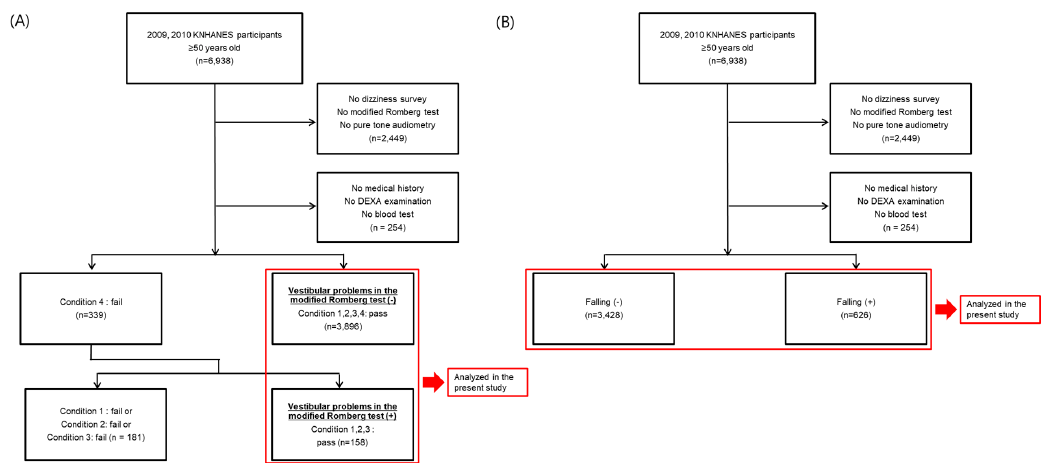
Figure 1. Schematic illustration of the method used for participant selection. ( A ) The participants with vestibular problems in the modified Romberg test were compared with control participants. ( B ) The participants with histories of falling were compared with control participants.